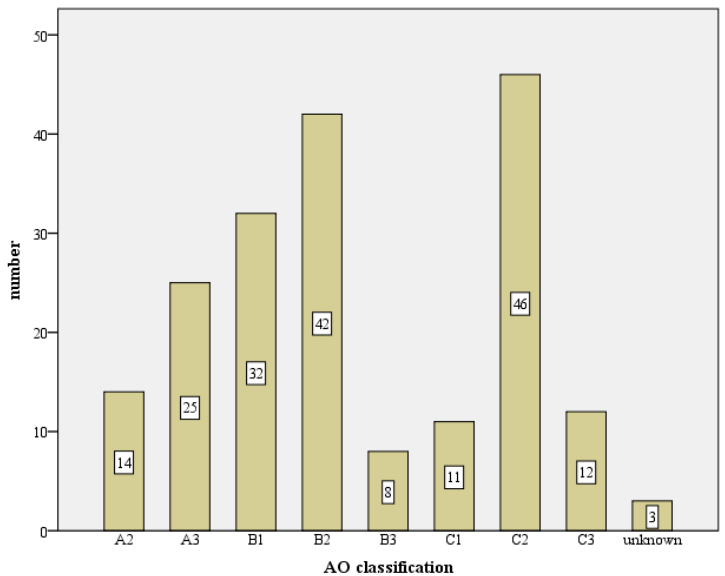
Figure 4. Absolute fracture distribution of the total collective, based on the AO-classification, total number n = 1047 (X-axis: AO-classification, Y-axis: number).